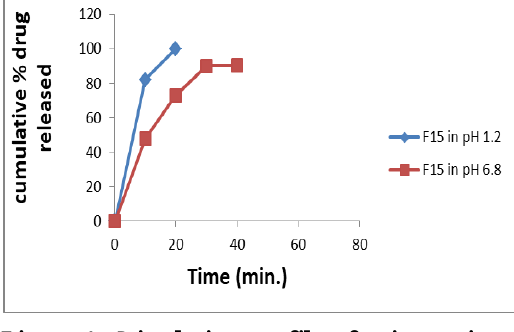
Figure 1. Dissolution profile of mirtazapine ( F15) nanosuspension in 0.1 N HCl (pH 1.2) and in phosphate buffer (pH 6.8) at 37  C . Table 6. Flow properties of prepared blends of mirtazapine incorporating drug nanoparticle s. Formula